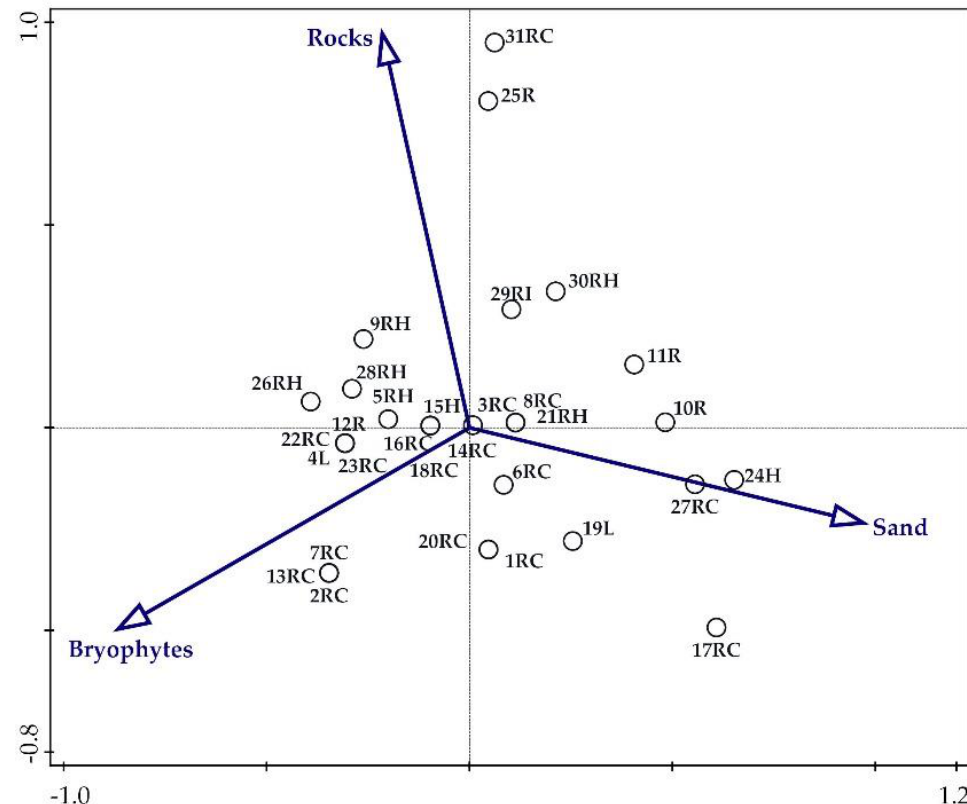
Figure 2. PCA biplot (explained variation (cumulative): 60.33% for Axis 1; 88.85% for Axis 2) depicting the types of springs (H — helocrene; L — limnocrene; R — rheocrene; RC — rheocrene cave; RH — rheohelocrene; RI — rheocrene intermittent) and the percentages of substratum categories for the 31 sampling locations; sampling codes from 1 to 31, as in Table 1.